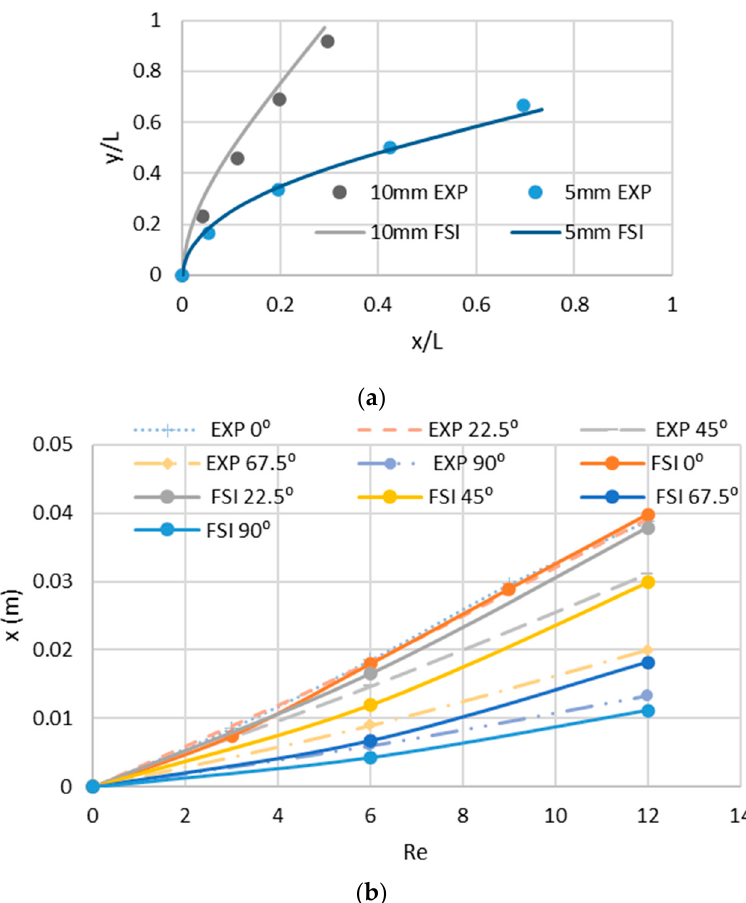
Figure 9. ( a ) Bending comparison at different thicknesses, Re = 9 clamping angle 0°; ( b ) Bending verses Reynolds number for different clamping angles, thickness 10 mm.